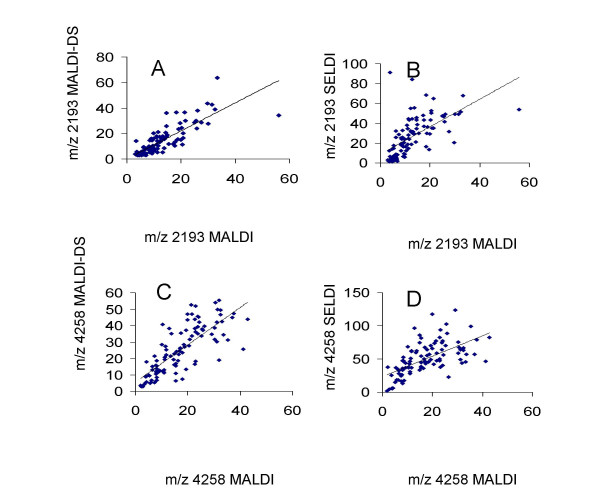
Correlation between peak intensities in different datasets. Figure 4 shows the correlations between peak intensities in the MALDI and MALDI-DS and MALDI and SELDI datasets for 2 peaks: m/z 2193 (A & B) and m/z 4258(C & D).